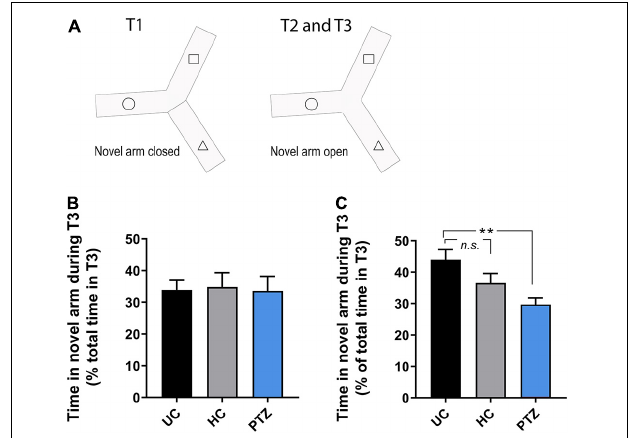
FIGURE 1 | Zebrafish that experienced seizures as] larvae showed learning deficits at 12–14 weeks of age. (A) Diagram of the y-maze paradigm. The arm with the dotted line represents the randomly chosen starting arm; the blocked off arm represents the novel arm. Fish freely explored the first two arms during Trial 1, and all three arms in Trial 2. Fish were then removed from the maze for the designated inter-trial interval (ITI), then returned to the starting arm to explore all three arms for Trial 3. (B) In 9.5-week old zebrafish, no experimental group showed robust, consistent recall of the novel arm in Trial 3, even with a shorter ITI of 60 min [ p = 0.975; F ( 2 , 33 ) = 0.025 by ANOVA; n = 13 UC, 12 HC, 11 PTZ]. (C) By 12–14 weeks old, the untouched controls (UC) group showed a strong recall of the novel arm at 90 min ITI. However, the performance of zebrafish in the pentylenetetrazole (PTZ) group was significant impaired compared to the UC controls [ p = 0.004, F ( 2 , 40 ) = 6.223 by ANOVA; post-hoc PTZ vs. UC p = 0.002. ** indicates p <